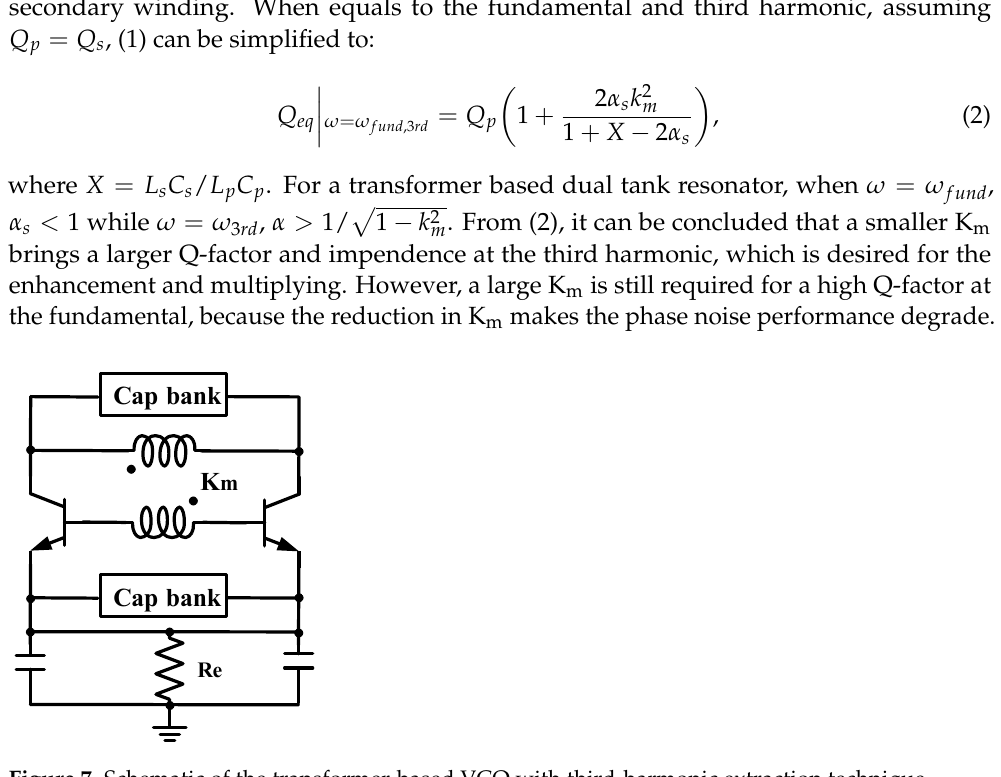
Figure 6. Schematic of the proposed LO chain.